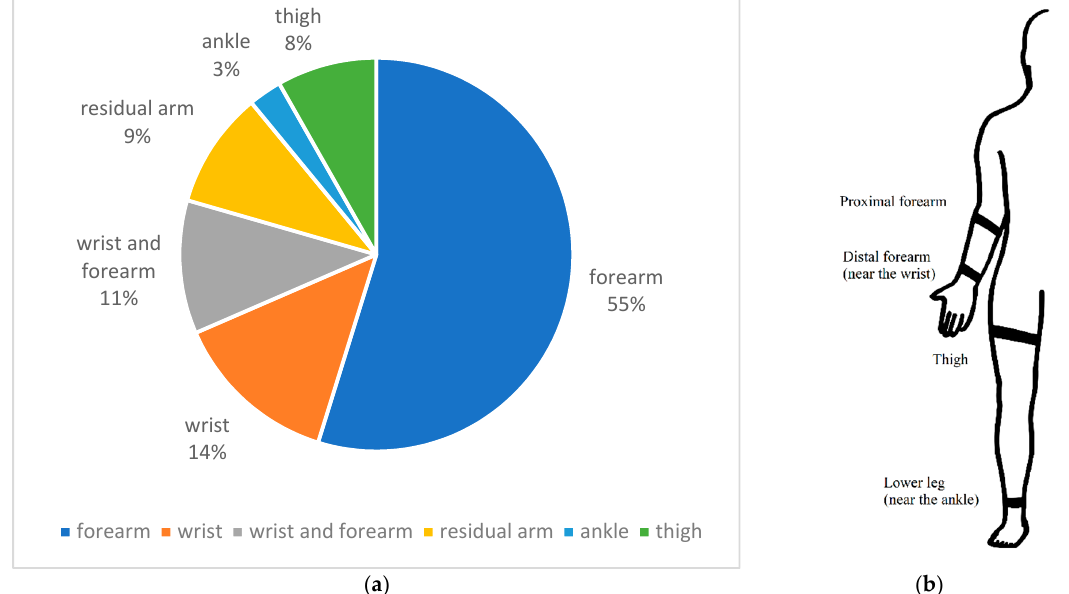
Figure 7. Information and depiction about the FMG sensor placement. ( a ) Percentage of sensor placement found in the literature ( n = 73). ( b ) Depiction of FMG sensor placement.